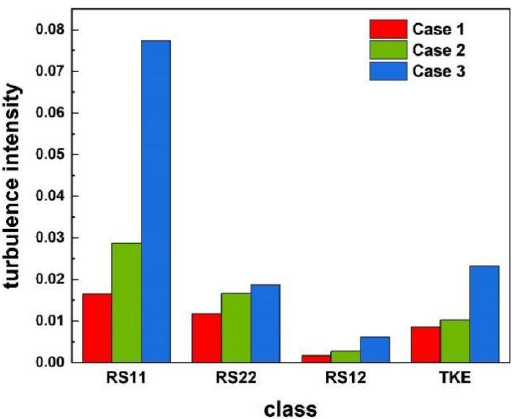
Figure 8. Peak value of turbulence intensity along streamwise direction for three cases: ( a ) 𝑅𝑆11 ;